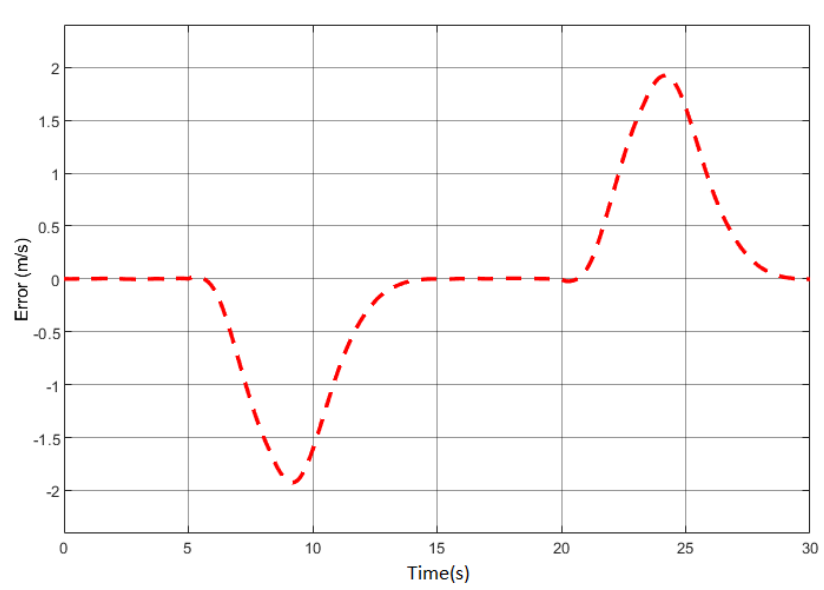
Figure 11. Velocity